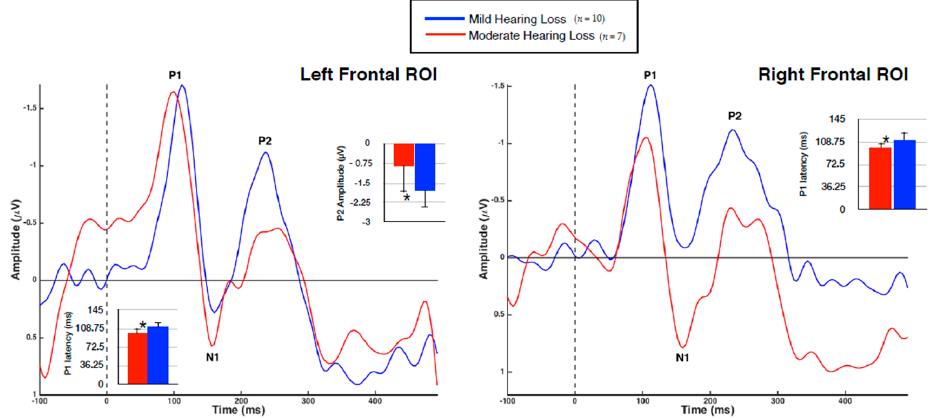
Figure 4. Group Averaged VEPs of Frontal Cortical ROIs. Average VEP waveforms in the left and right frontal ROIs for the MILD hearing loss group ( n = 10) are represented in blue, while the MOD hearing loss group ( n = 7) is represented in red. VEP waveforms are shown as amplitude functions (vertical axis in microvolts) over time (horizontal axis in milliseconds). Bar graphs illustrate significant differences, with one asterisk denoting significance at p < 0.05.